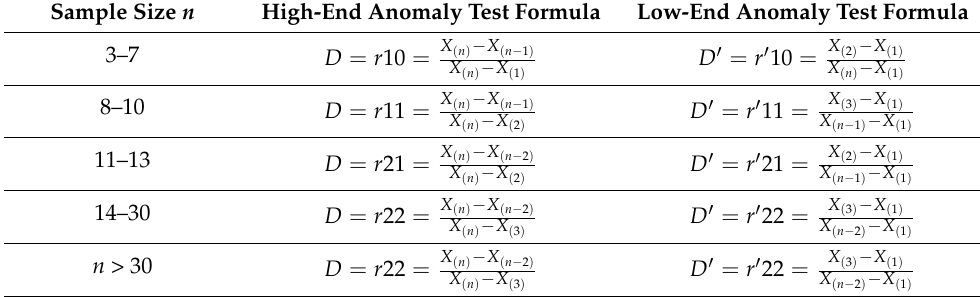
Table 3. Dixon formula